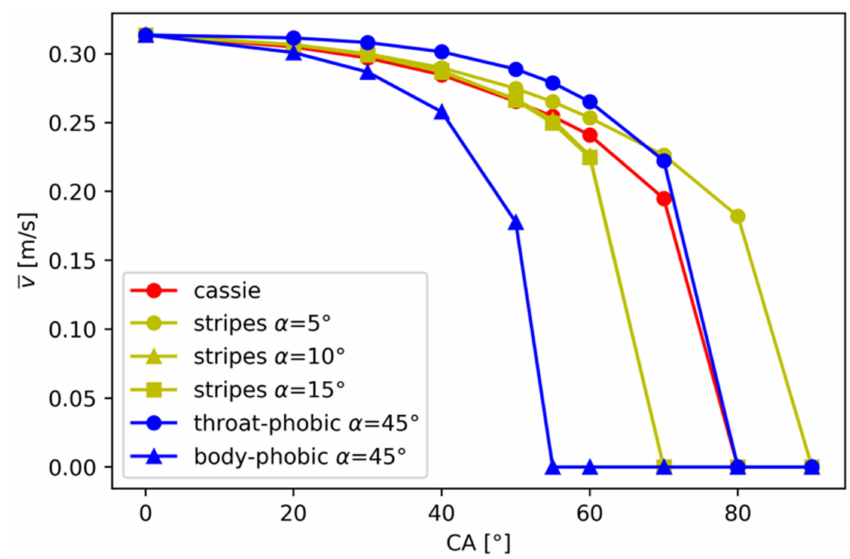
Figure 18. Comparison of coatings with 1:1 ratio of surface areas with hydrophilic and reduced wettability as well as the corresponding homogeneous coating according to the Cassie equation.